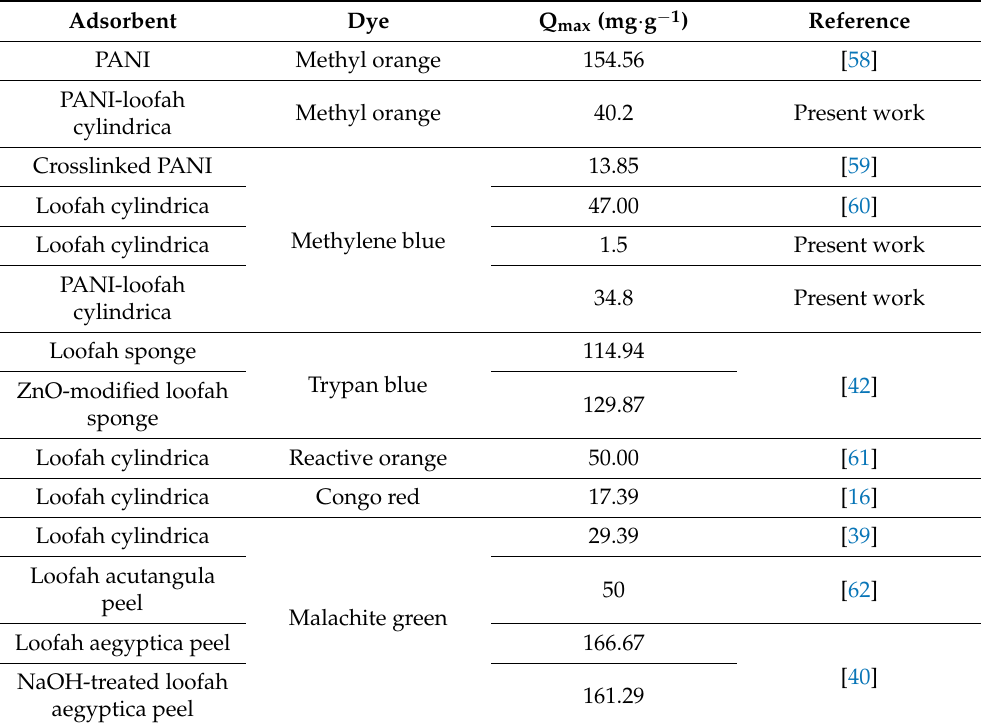
Table 1. Comparison among the results obtained in the present work and others from the scientific literature for the adsorption of different dyes on several loofah-based adsorbents.